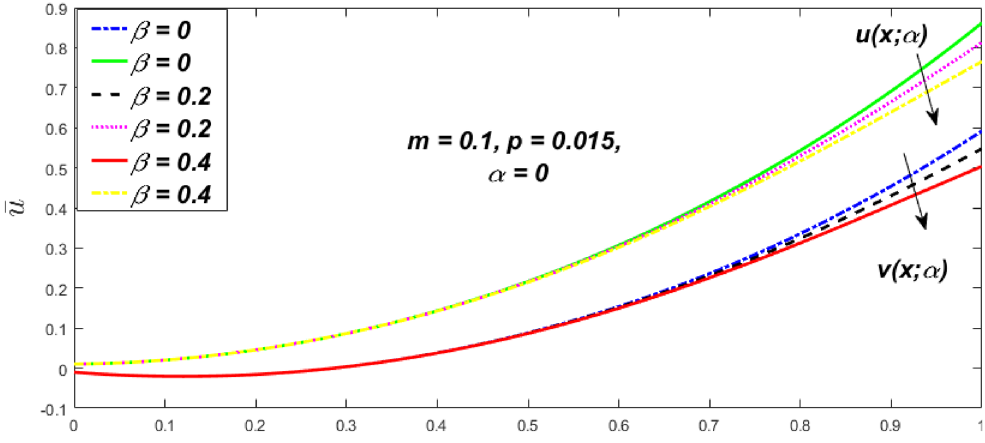
Figure 28. Fuzzy velocity profiles for the impact of β .